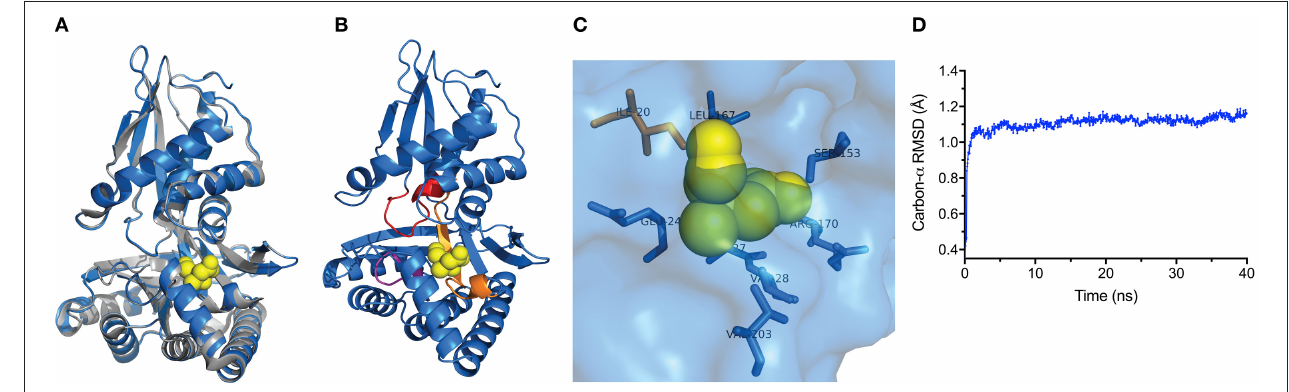
FIGURE 2 | TeMVK homology model is structurally similar to L. major MVK. (A) Homology molecular modeling of TeMVK using the crystal structures of LmMVK (2HFU and 2HFS, PDB). TeMVK (blue) and LmMVK (gray) are superimposed and mevalonate molecule (yellow) indicated within the catalytic cleft. (B) Cartoon representation shows three motifs (orange, red and magenta) that assemble the deep catalytic cavity in TeMVK. (C) Structural arrangement of TeMVK residues known to interact with mevalonate in LmMVK. (D) Average RMSD for carbon- α (in angstroms) throughout the molecular dynamic simulation.